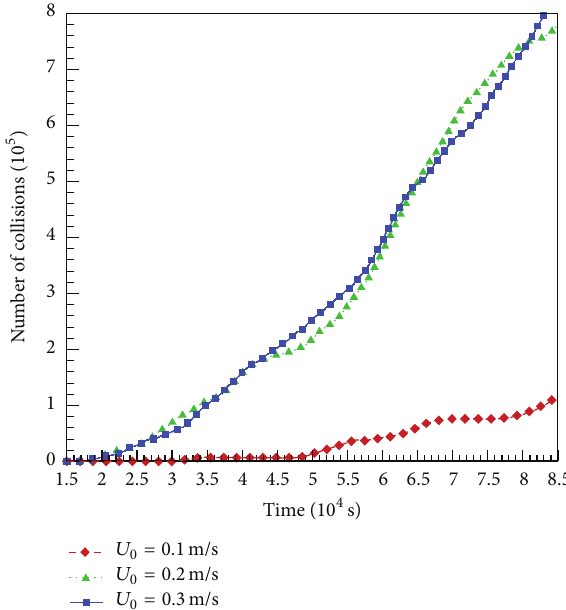
Figure 6: Comparison of collision number with different 𝑈 0